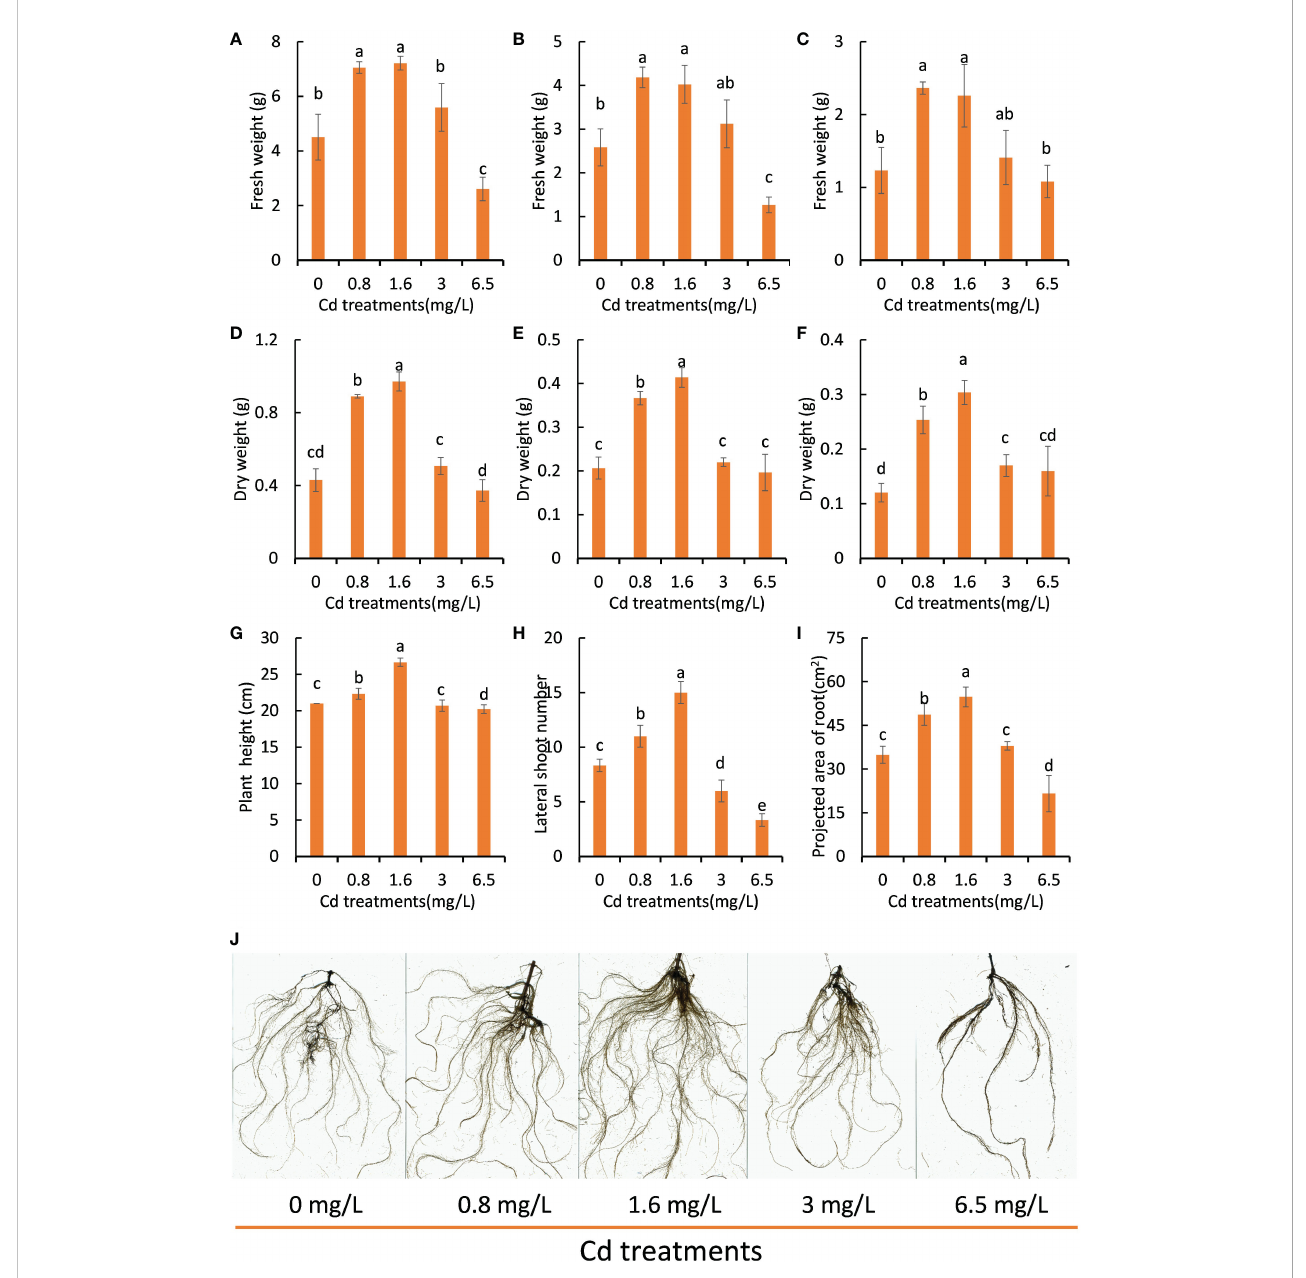
FIGURE 1 The growth performance of peppermint young plants under different concentrations of Cd treatments. (A – C) , fresh weight of leaves and shoots and roots, respectively; (D – F) , dry weight of leaves and shoots and roots, respectively; (G) , the height of young plants; (H) , the number of lateral shoots; (I) , projected area of root; (J) , root morphology. The growth performance of young plants was determined following 7 days of Cd stress treatments. Each value is presented as means ± standard error from three repeats. Statistical differences (p ≤ 0.05) between treatments are compared in the SPSS software and indicated using different letters above the